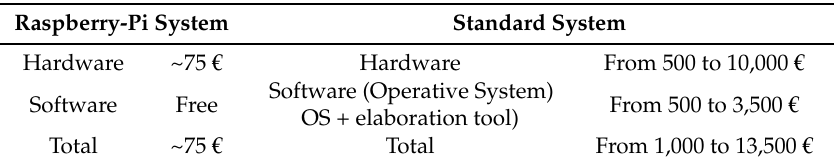
Table 1. Costs comparison between the Standard and the Raspberry